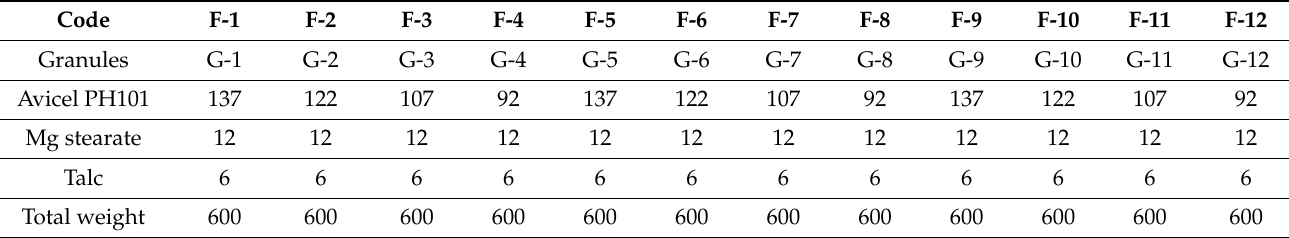
Table 7. Composition (in mg) of acyclovir